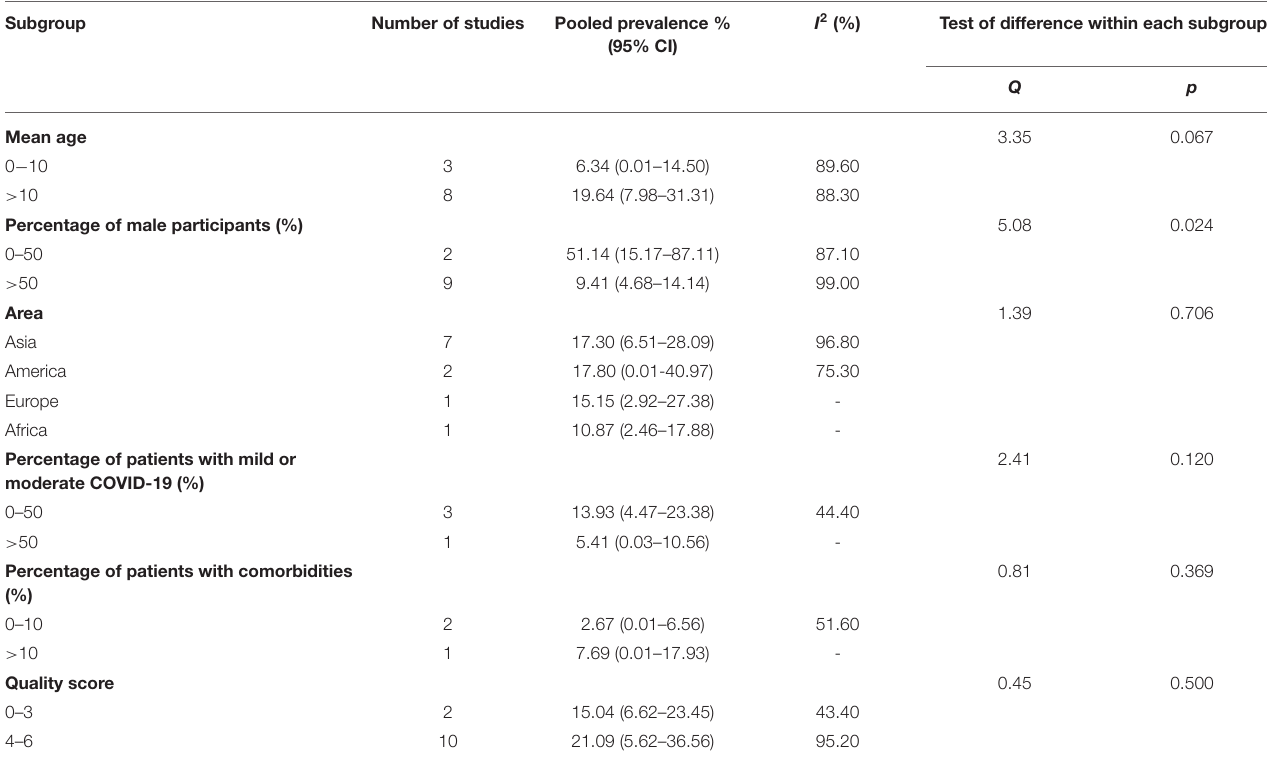
TABLE 2 | Subgroup analysis for smell dysfunction.